Question: What does this figure show? Answer in one sentence.
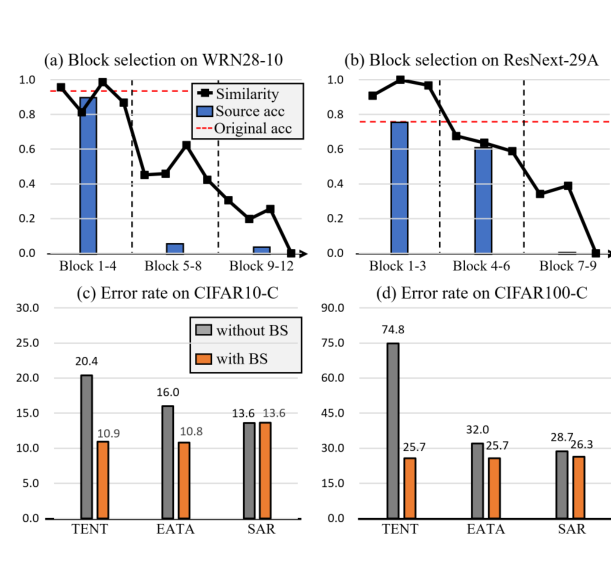
Answer: Illustrations of our proposed block selection results (a, b) and classification error rate (@level 1-5) for the gradual setting benchmark using other entropy minimization-based methods with or without block selection (c, d). Additionally, in (a) and (b), the source accuracy after the long-time adaptation (i.e., gradual setting benchmark) with selected blocks is shown in a bar graph.